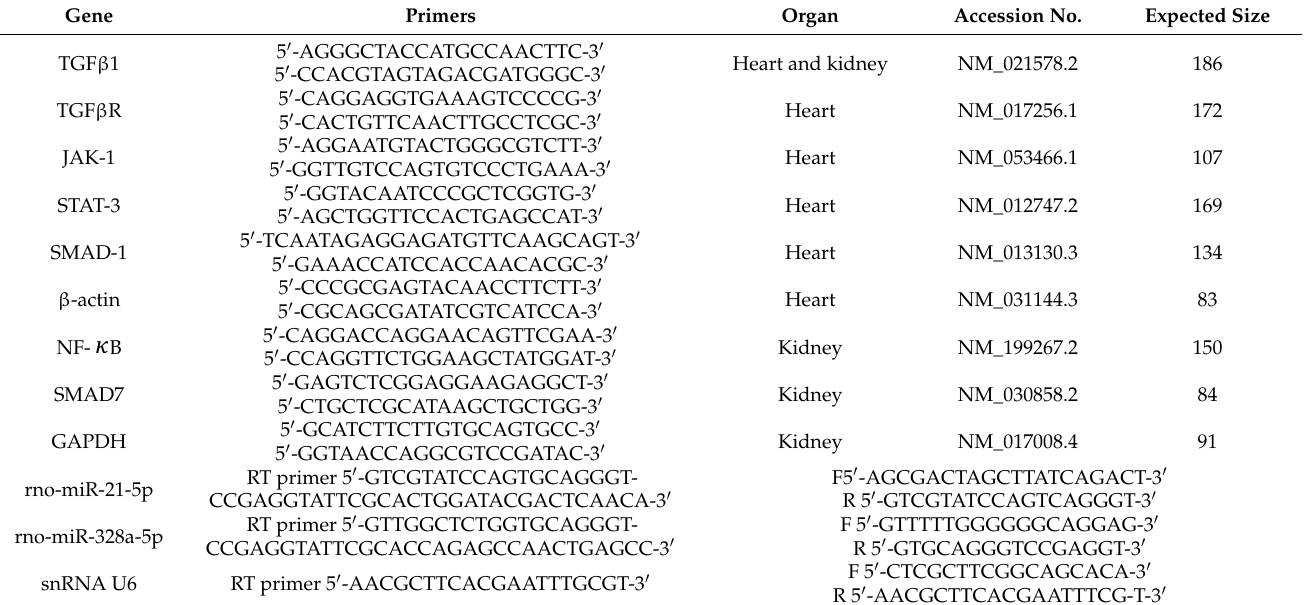
Table 1. Forward and reverse primer sequences for miRNA genes and the detected genes.